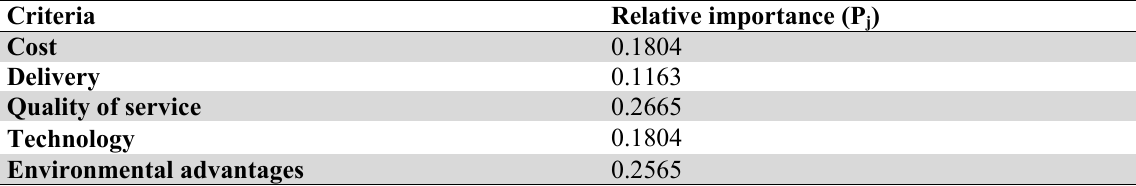
The weight of the main criteria